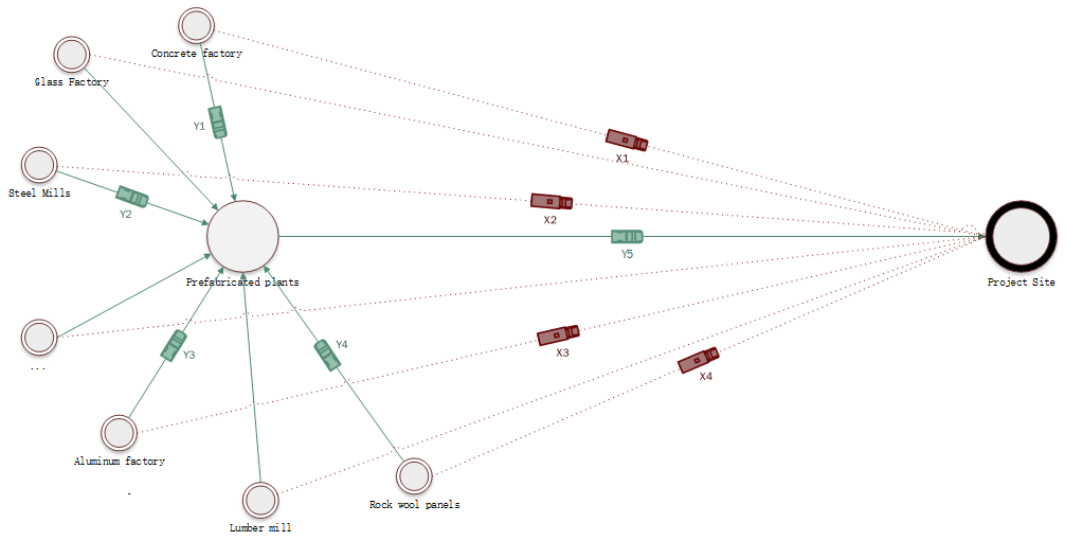
Figure 10. Comparison of transportation distance of B1